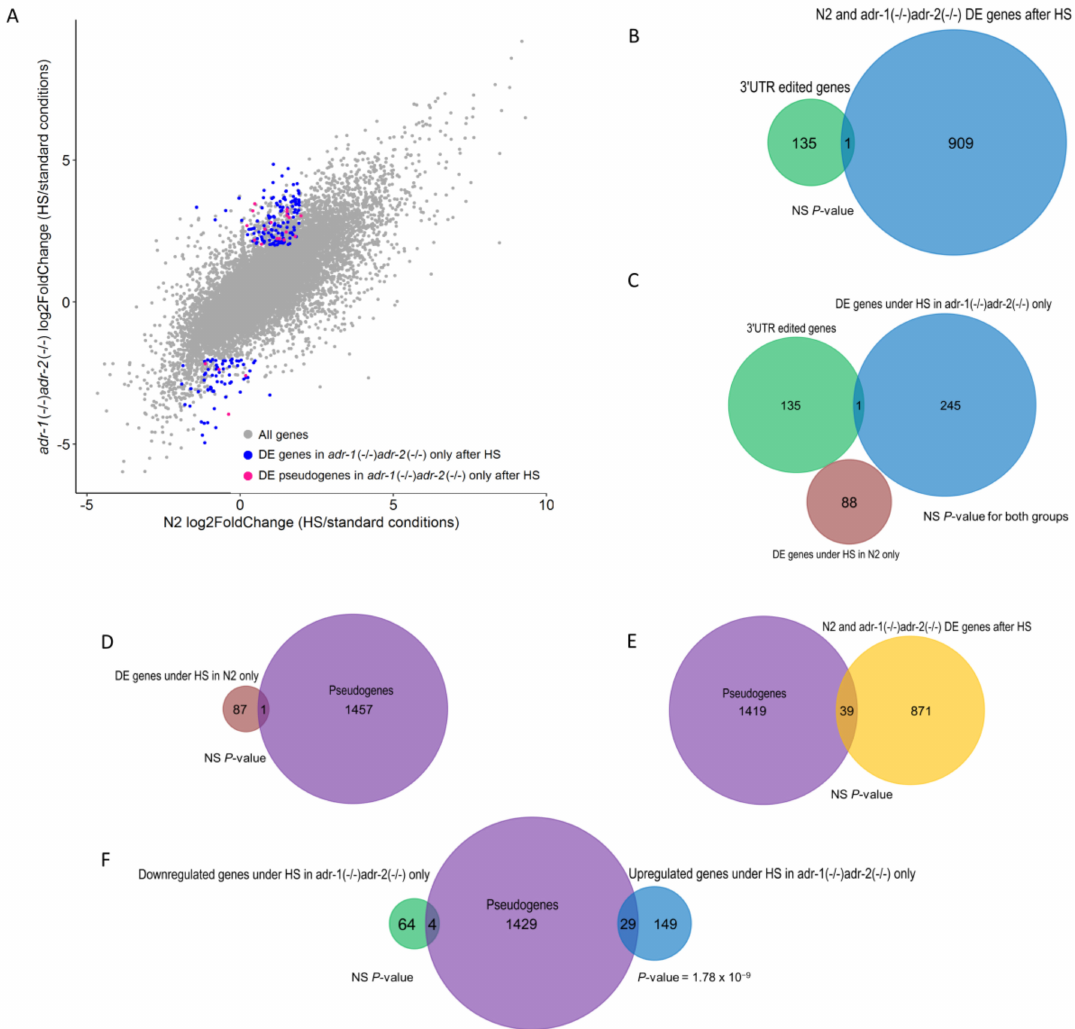
Figure 4. Long non-coding RNAs and pseudogenes are upregulated upon heat shock in ADAR mutants. ( A ) Scatter plot presenting log2 fold-change values (gene expression after heat shock vs. standard conditions) of the ADAR mutants compared to the wild-type (N2). Grey dots are all genes, blue dots are significant differentially-expressed genes specific to ADAR mutants, purple dots are significantly differentially-expressed pseudogenes specific to ADAR mutants. ( B , C ) Venn diagrams showing that genes edited at their 3’UTR are not enriched among genes that were differentially expressed under heat shock. The number of 3’UTR edited genes, differentially expressed in both N2 and the ADAR mutants, differentially expressed in the wild-type only, and differentially expressed in the ADAR mutants only are shown in purple, orange, red, and blue, respectively. ( D , E ) Venn diagrams showing that pseudogenes and lncRNAs are not enriched among genes that were differentially expressed in both ADAR mutants and wild-type or in wild-type only. The number of pseudogenes, differentially-expressed genes in N2 only ( D ), and differentially-expressed genes in both N2 and ADAR mutants ( E ), are shown in purple, red, and orange, respectively. ( F ) Venn diagram depicting that pseudogenes are significantly enriched among upregulated genes, which are specific to the ADAR mutant. The number of pseudogenes, the upregulated genes, and the downregulated genes are shown in purple, blue, and green, respectively. ( p -value >